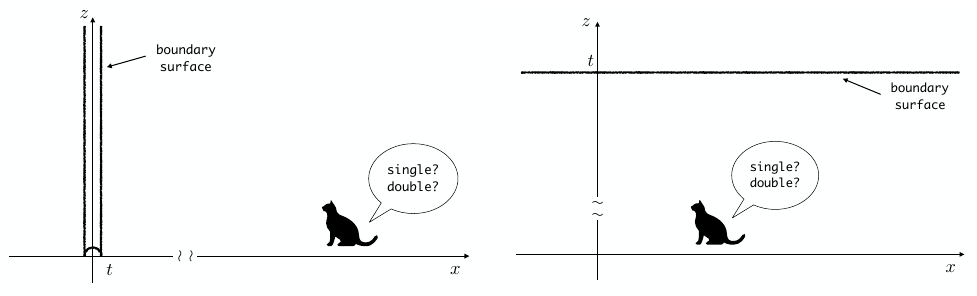
Figure 26 . An observer at large x (left (cid:12)gure) or at large t (right (cid:12)gure) can hardly distinguish between a single joining quench and a double joining